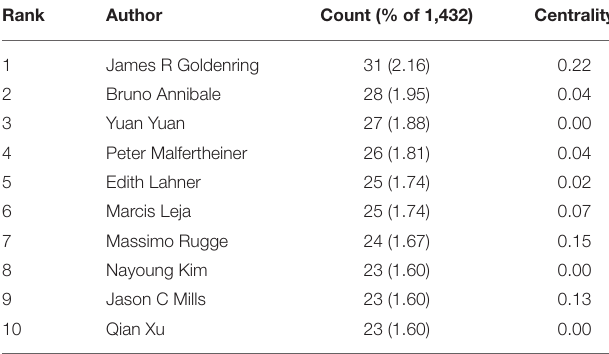
TABLE 2 | The top 10 authors in AG research. the disciplinary sources. The orange path in Figure 5 indicates that the studies that belong to